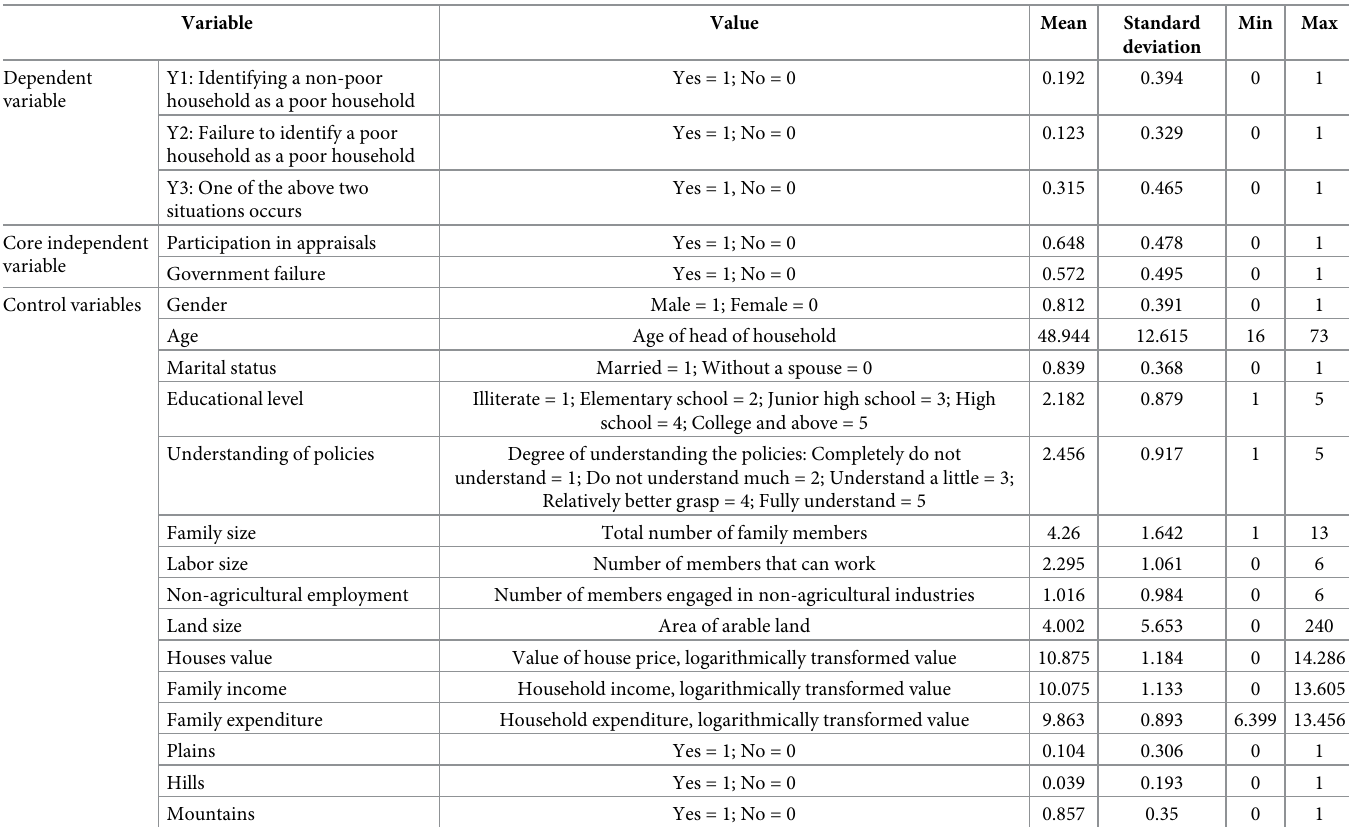
Table 1. Summary of the